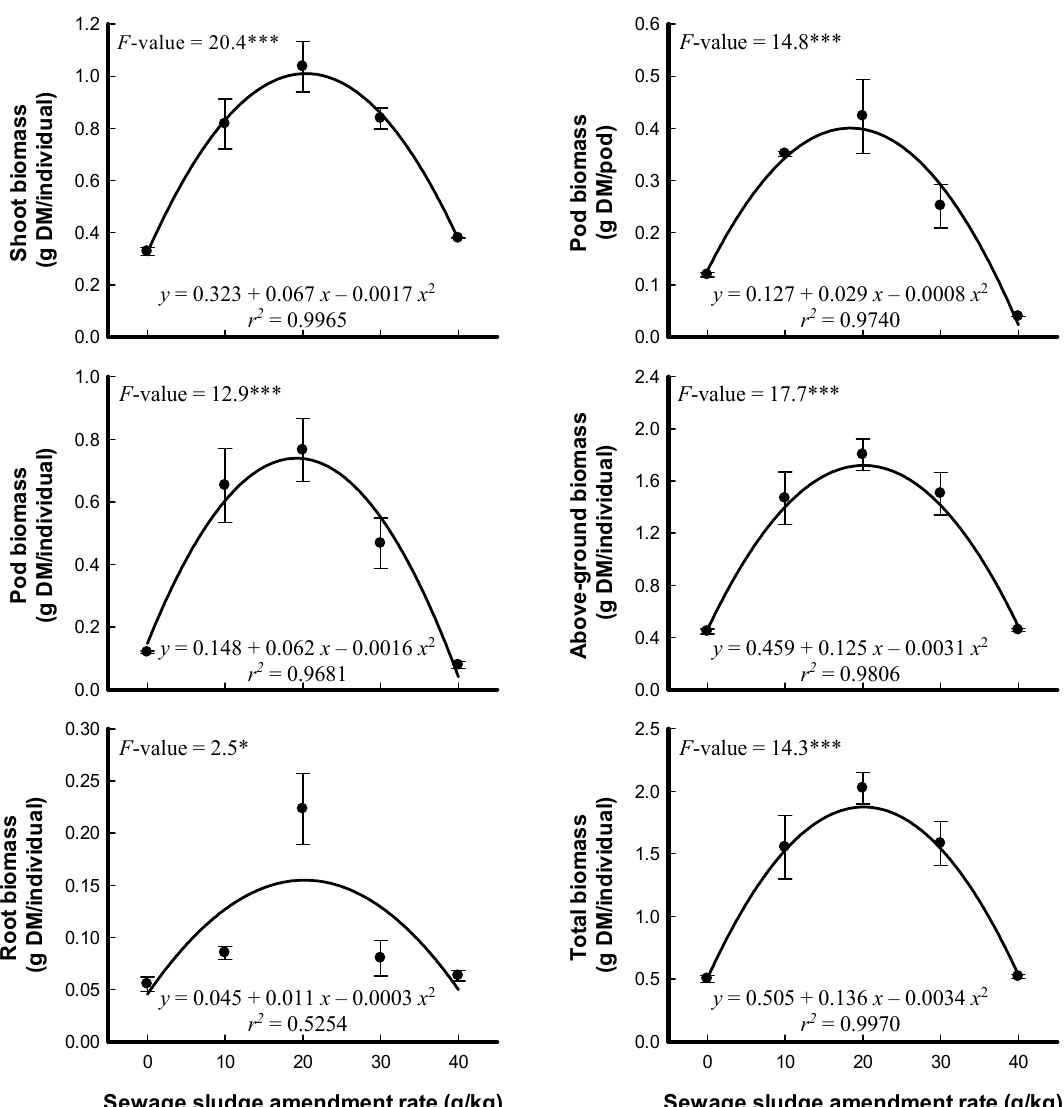
Figure 3. Effects of different sewage sludge amendment rates on the biomass of Pisum sativum that had been grown for 57 days (means ± standard error, n = 6). F -values represent a one-way ANOVA and degrees of freedom ( df ) = 4. *: p < 0.05, ***: p < 0.001.